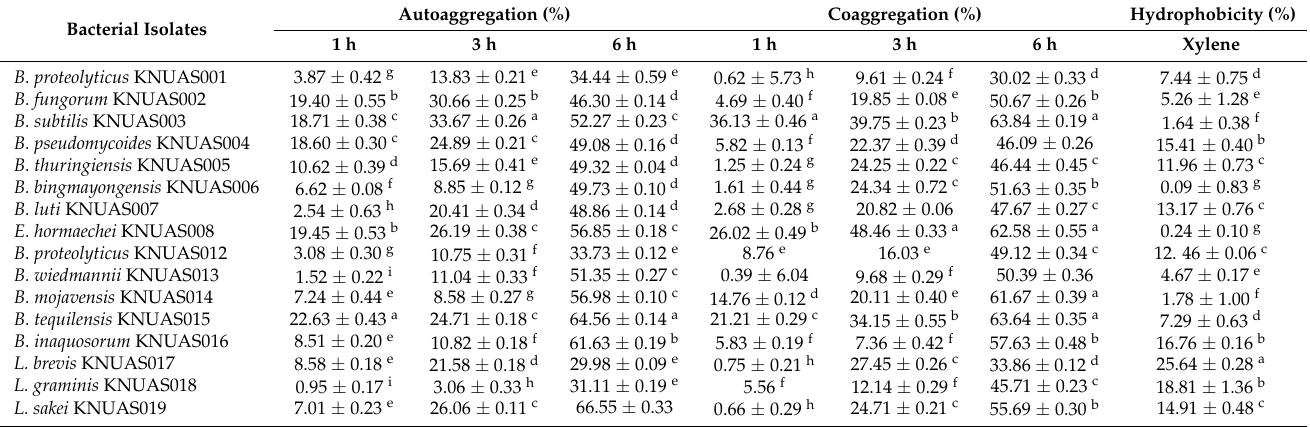
Table 3. Autoaggregation, coaggregation, and hydrophobicity of isolated bacterial strains from fermented Korean foods to simulated gastric juice and bile salts. The different superscript letters follow values indicating the significance among the samples ( p <